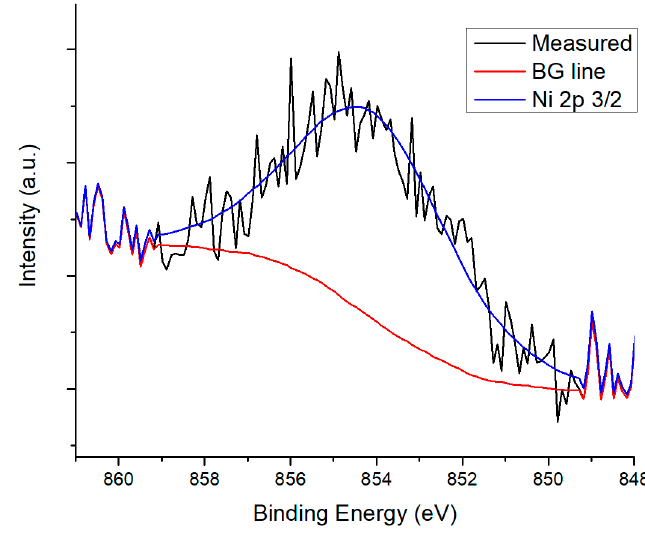
Figure 8. Ni 2p 3/2 component for IrNi/CeO 2 .